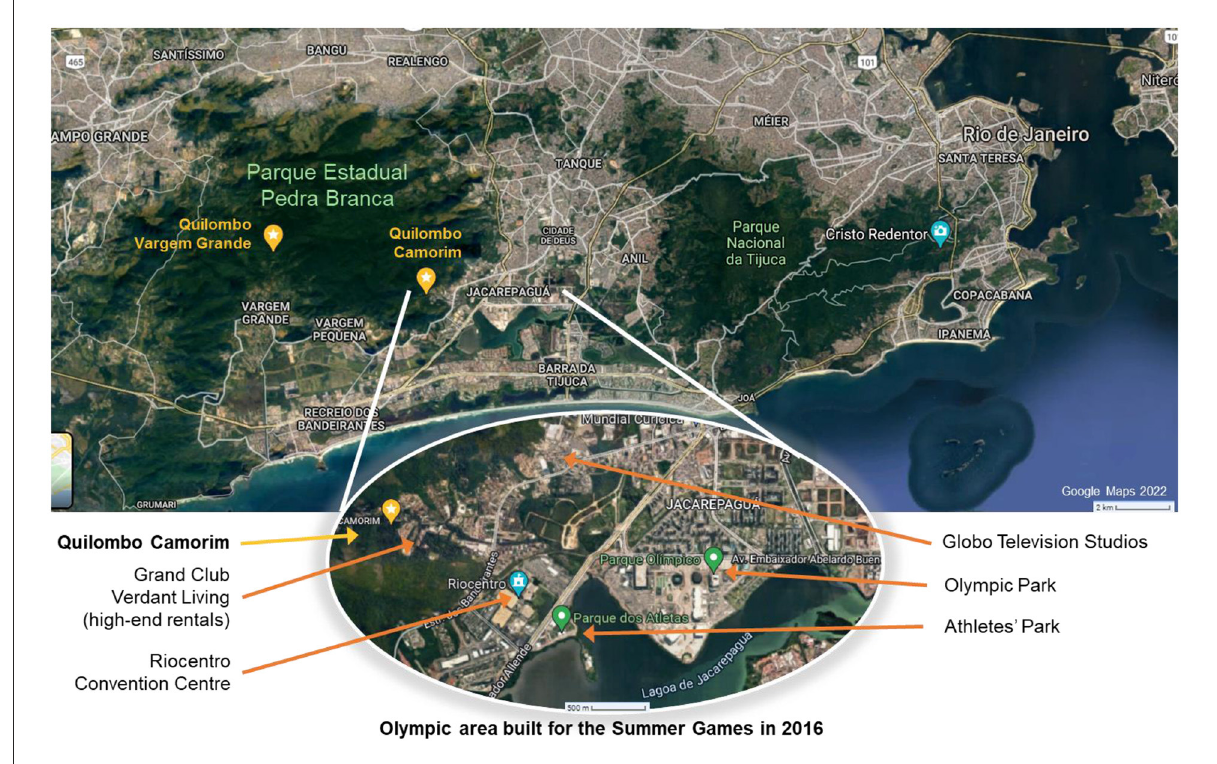
FIGURE5 Map showing the location of the two Quilombos in the quickly urbanizing West Zone of Rio de Janeiro. Source: Own elaboration with Google